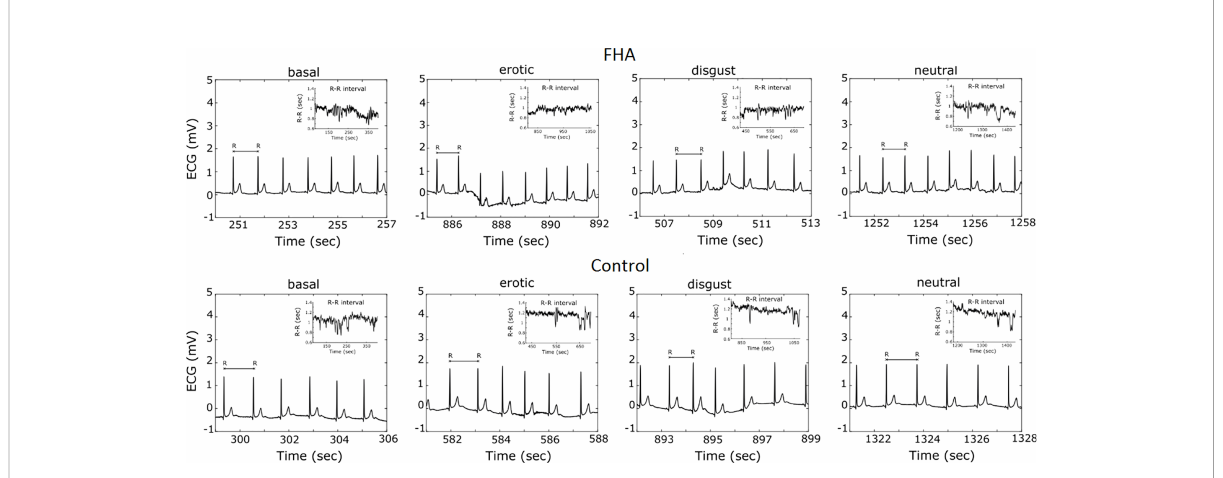
FIGURE 2 Example of Electrocardiogram recording and R-R- interval extraction in a casually selected FHA patient and Control